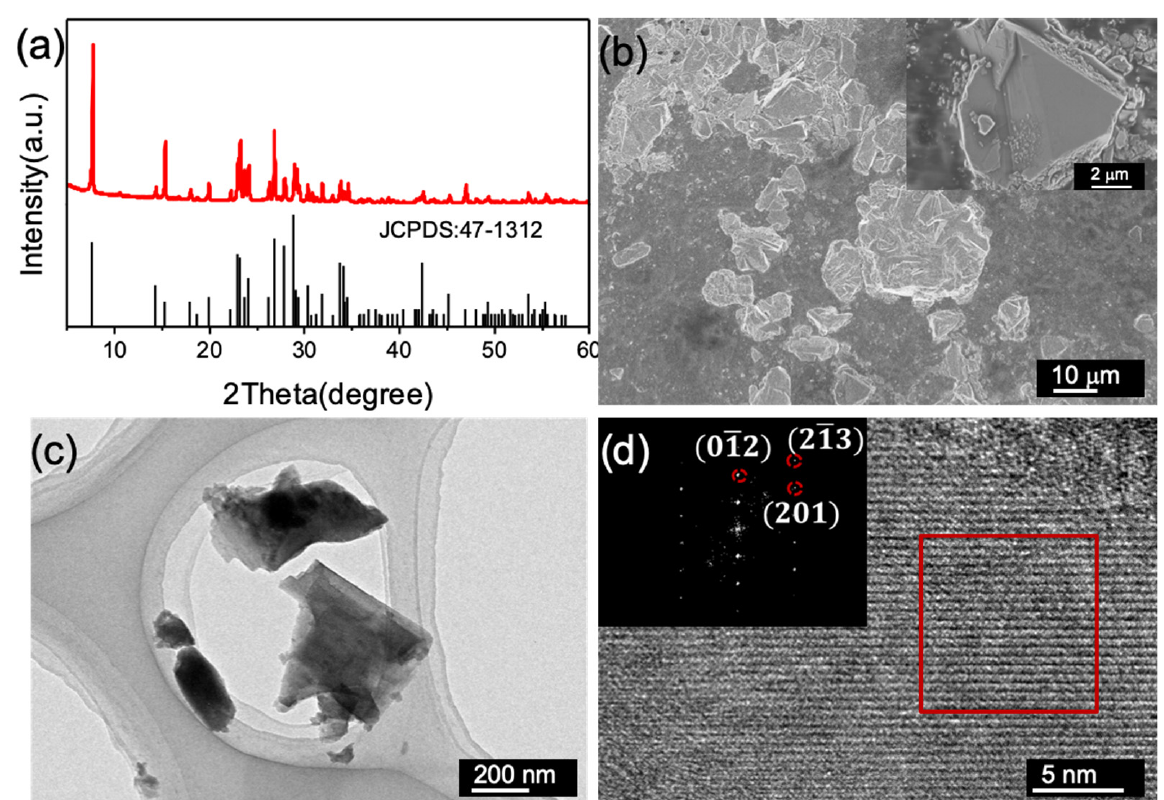
Figure 1. XRD patterns ( a ), SEM image ( b ), TEM image ( c ), and ( d ) HRTEM image and FFT pattern (inset) of the Cr 8 O 21 powder.